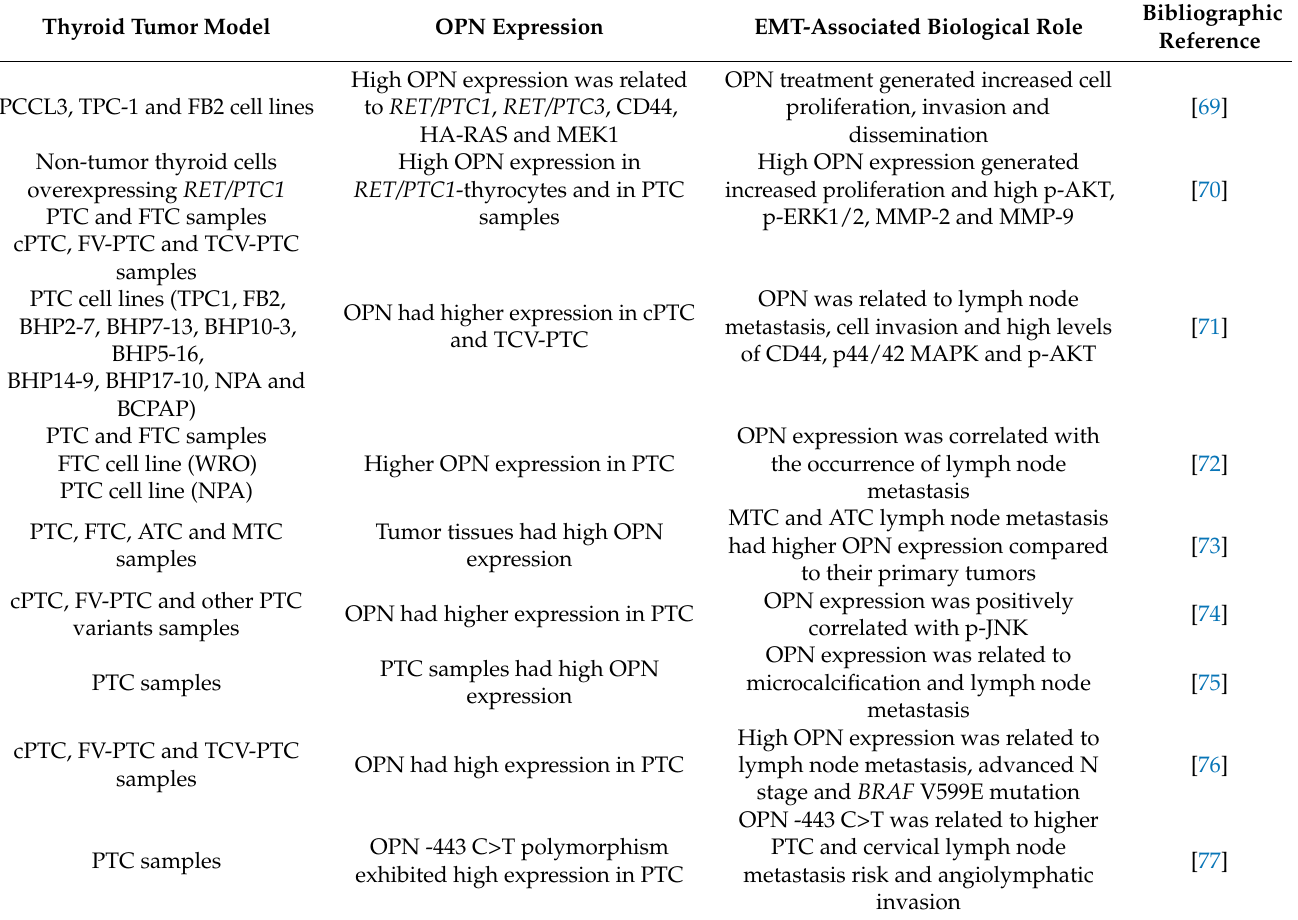
Table 2. OPN expression is associated with thyroid cancer progression in distinct subtypes. Thyroid Tumor